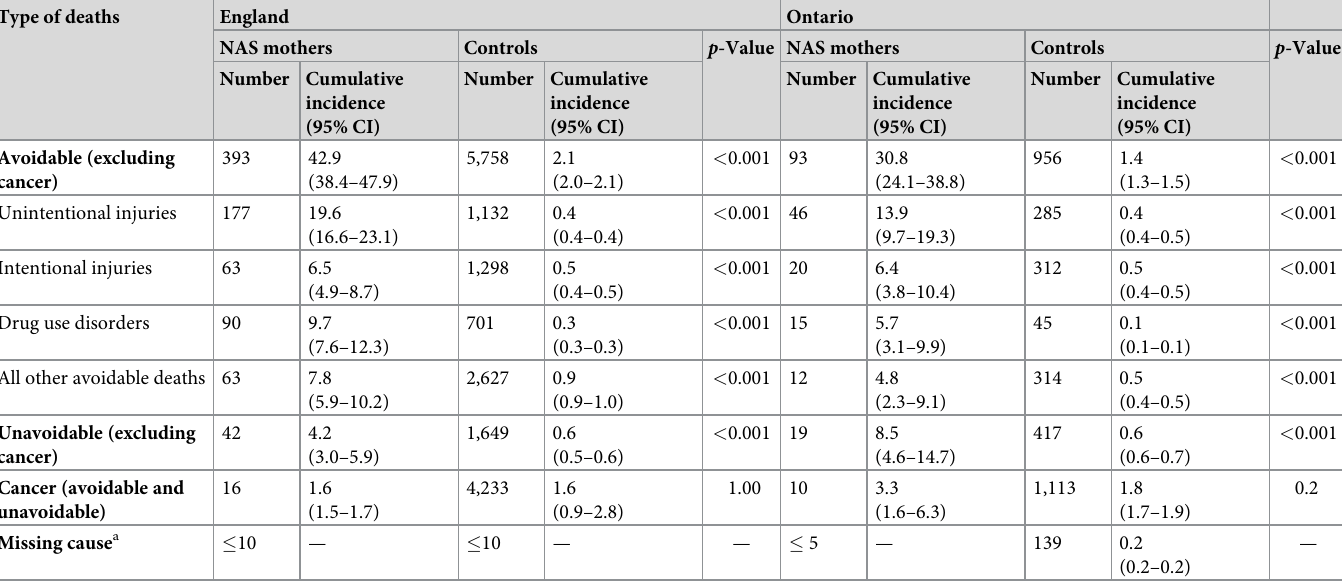
Table 5. Cause-specific mortality per 1,000 population among mothers (10-year cumulative incidence risk), April 1, 2002, to December 31,